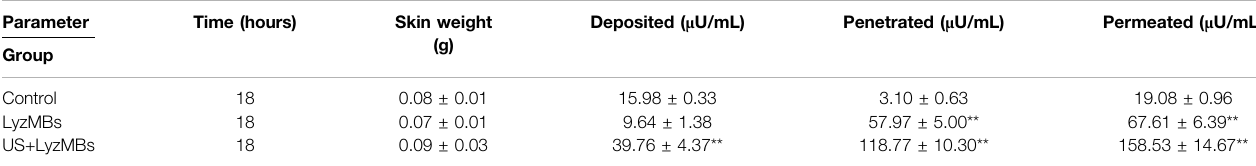
TABLE3| AmountsofLyzthatafter18 hhadpermeatedtheskin,depositedontheskin,andpenetratedacrosstheskin.Thetotalamount,penetrationanddepositionofLyz was greater in US+LyzMBs group than in other two groups (** p < 0.01). Data are mean ± SEM values. Parameter